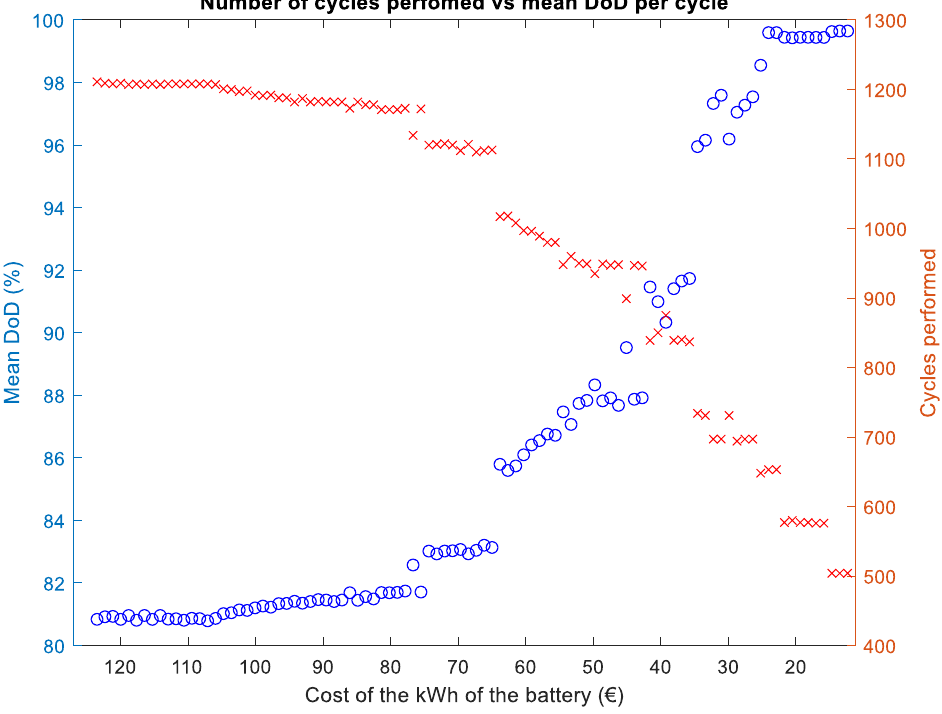
Figure 12. Power consumption (kW) comparison with and without the battery (iteration 100).